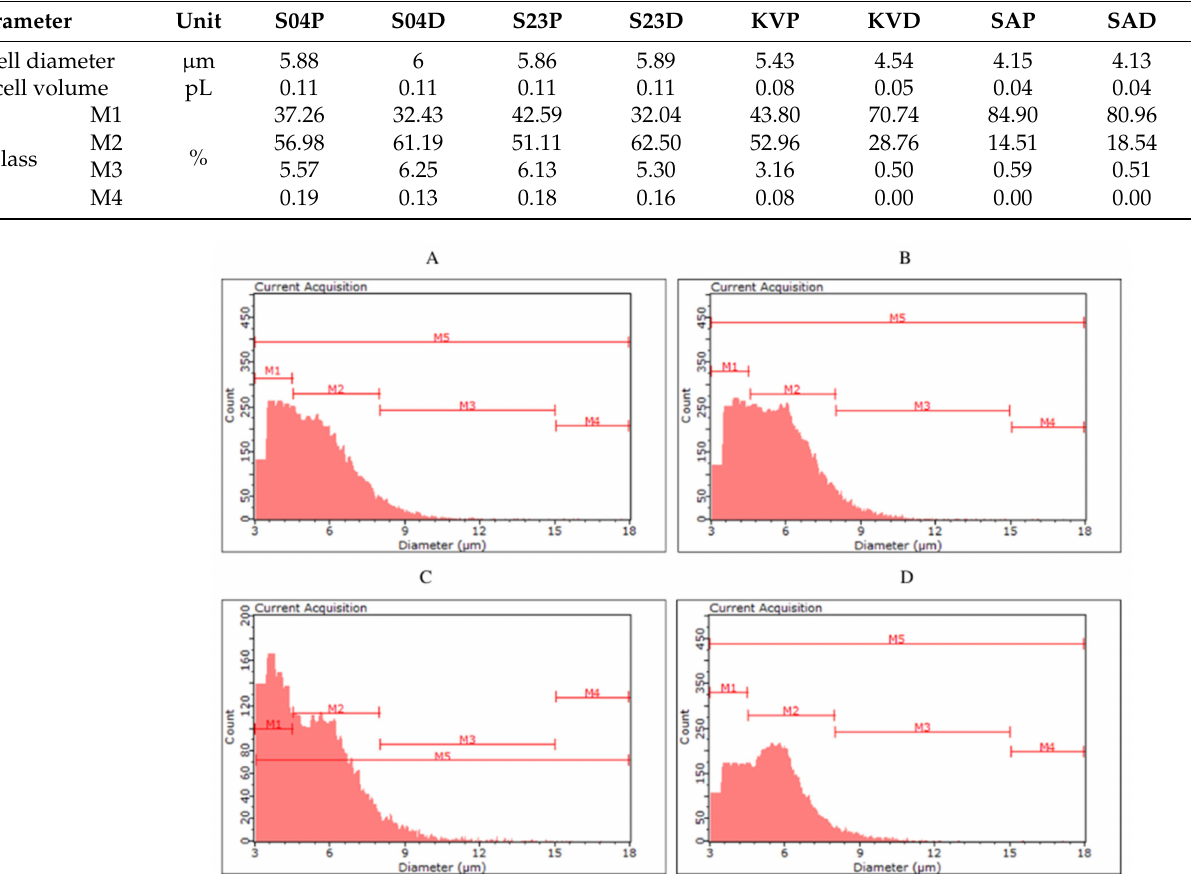
Figure 2. Histograms of yeast cell size in the yeast biomass after the main fermentation by the top fermentation yeast Saccharomyces cerevisiae (( A )—S04P, ( B )—S04D) and by the bottom